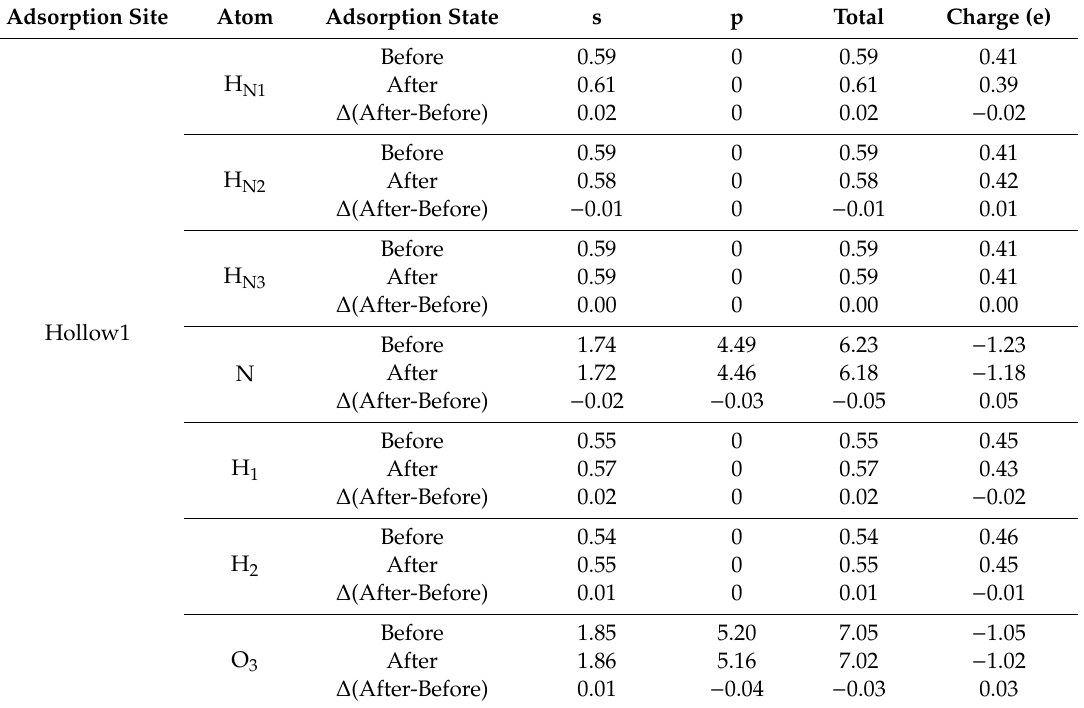
Table 5. Mulliken charge populations of atoms before and after NH 3 adsorption on “Hollow1” of kaolinite (001)